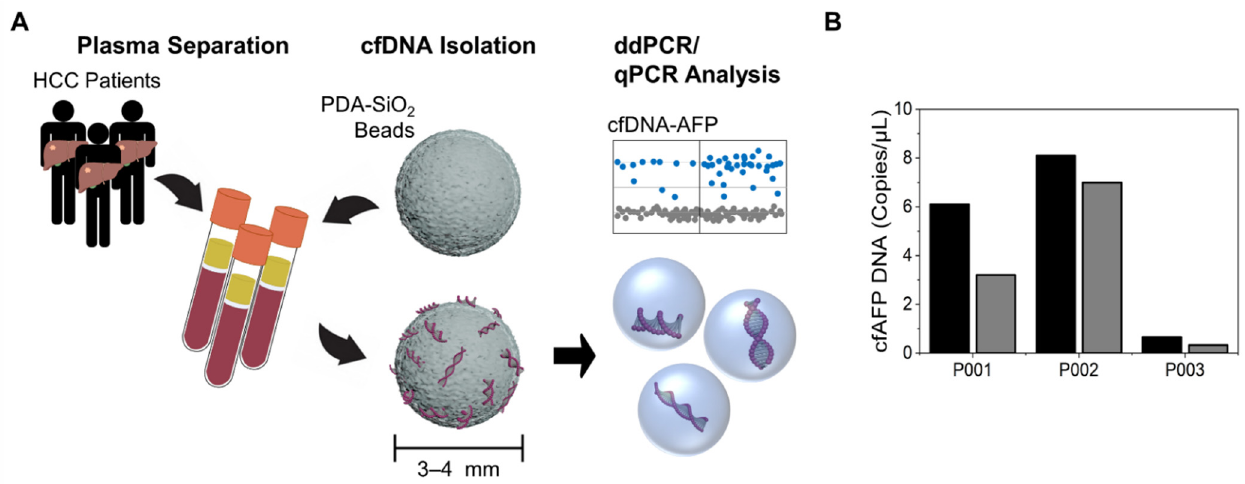
Figure 1. Enhanced detection of cfDNA for its use as a biomarker for the diagnosis and prognosis of HCC. ( A ) A schematic diagram illustrating the cfDNA detection and analysis methods using PDA ‐ SiO 2 beads. ( B ) The copy numbers of plasma cfAFP ‐ DNA isolated from human plasma samples using either PDA ‐ SiO 2 beads (black) or QIAamp DNA mini ‐ kit (gray).